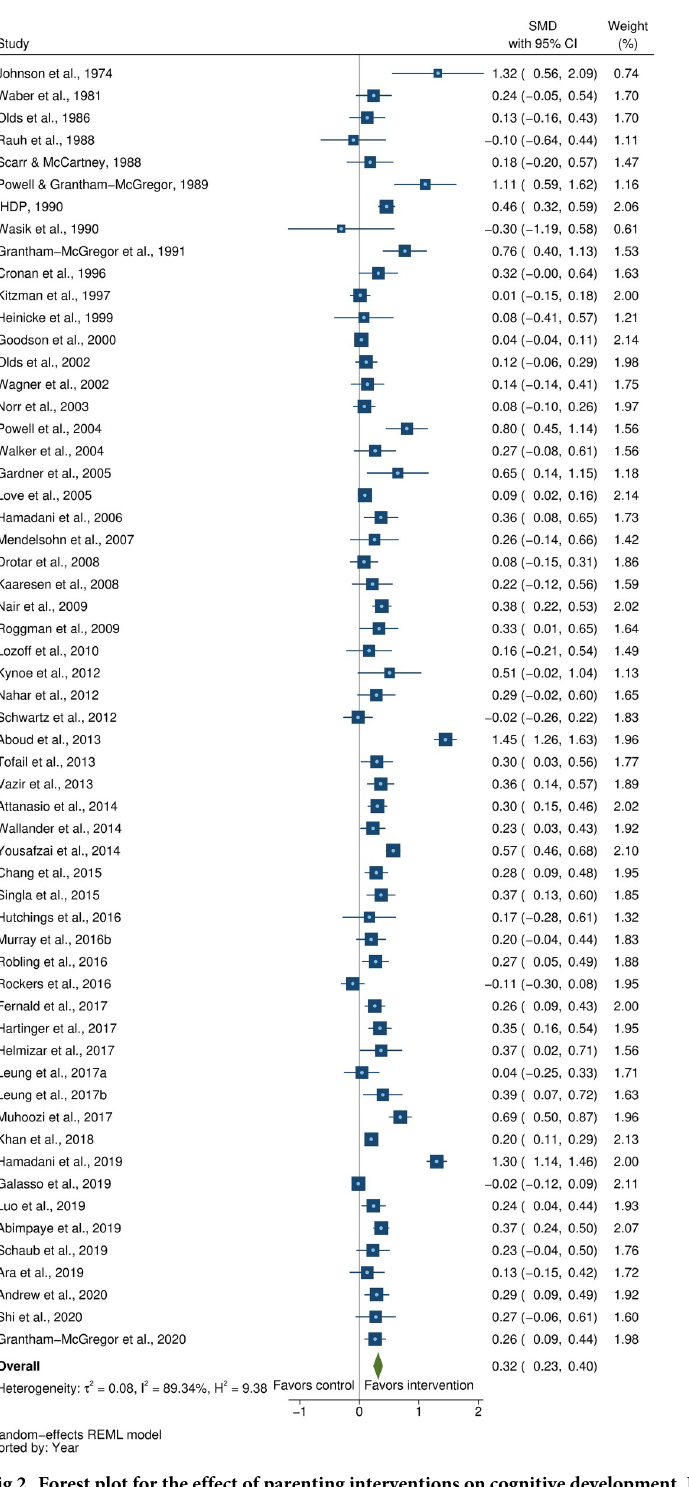
Fig 2. Forest plot for the effect of parenting interventions on cognitive development. Blue squares represent the SMD for each study, with the size of the square being proportional to the study weight. The whiskers extending from each side of the square represent the range of the 95% CI. The green diamond shows the overall pooled effect size using a random-effects model, which is centered at the point estimate and the diamond width representing the 95% CI. SMD, standardized mean